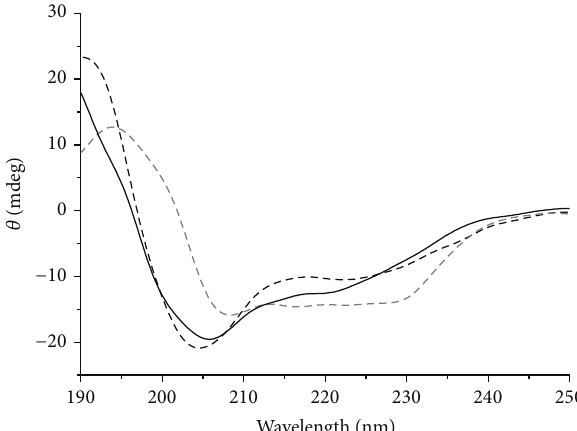
Figure 3: CD spectra of zinc finger proteins. Dark dashed line is ZNF191(243-368), gray dashed line is His 6 -ZNF191(243-368), and dark solid line is ZNF191(243-368)-His 8